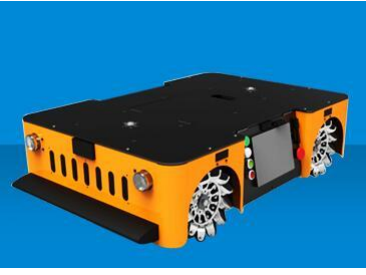
Figure 7. Outlook of